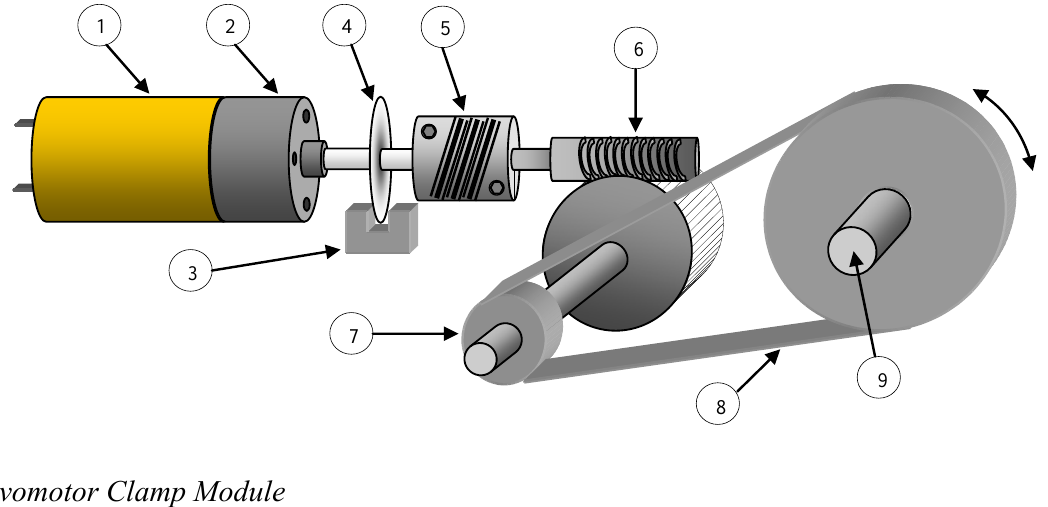
Figure 4. Servomotor arm module and mechanical